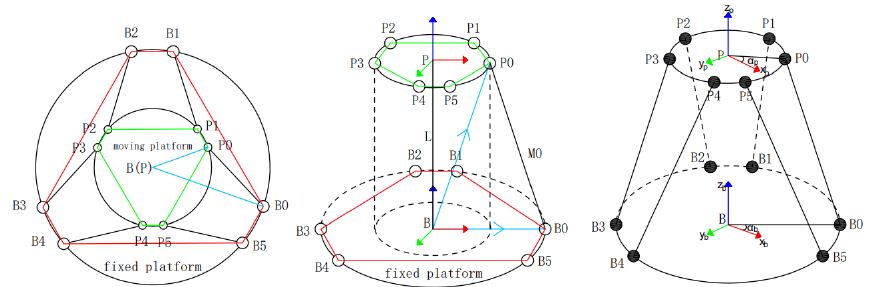
Figure 2. Structure diagram of FRR.